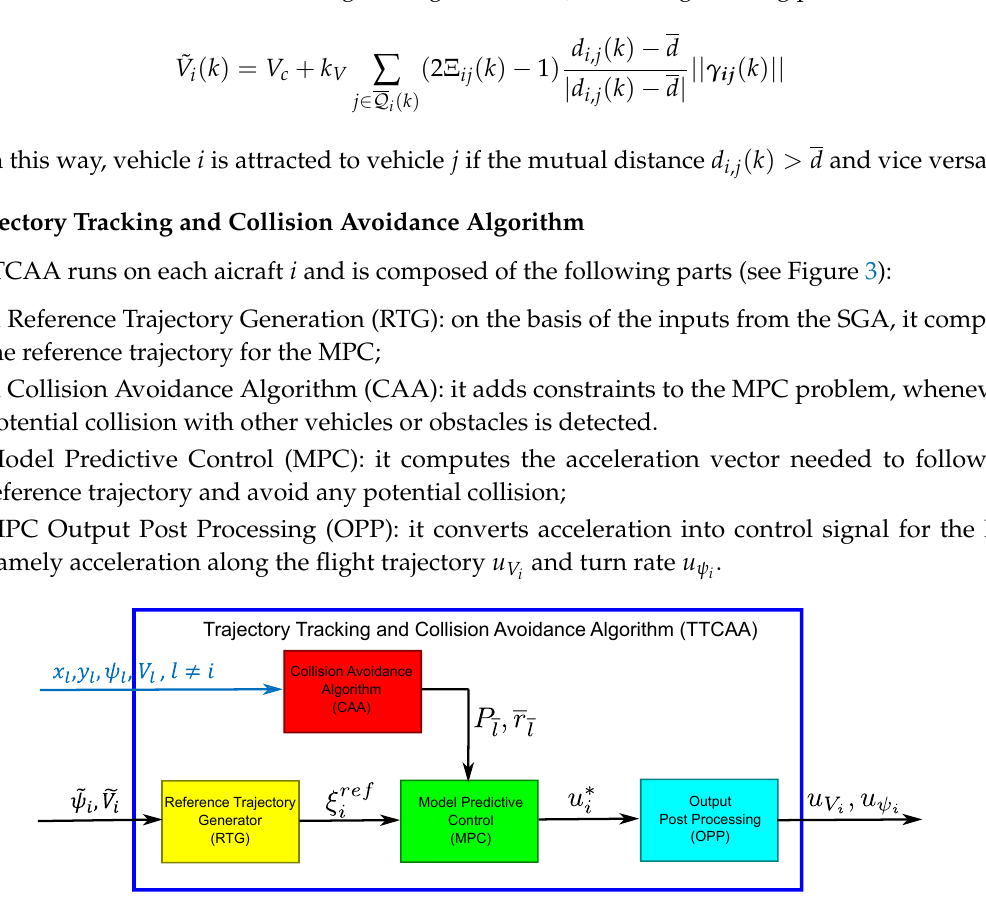
Figure 3. Trajectory Tracking and Collision Avoidance